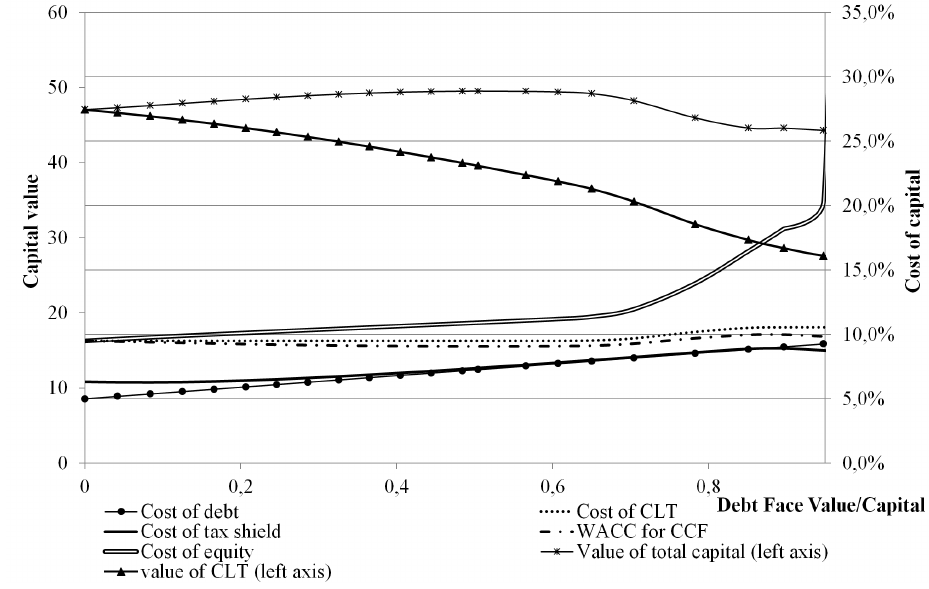
Fig. 2. Low-growth-low-risk companies without tax optimization g = 1%,